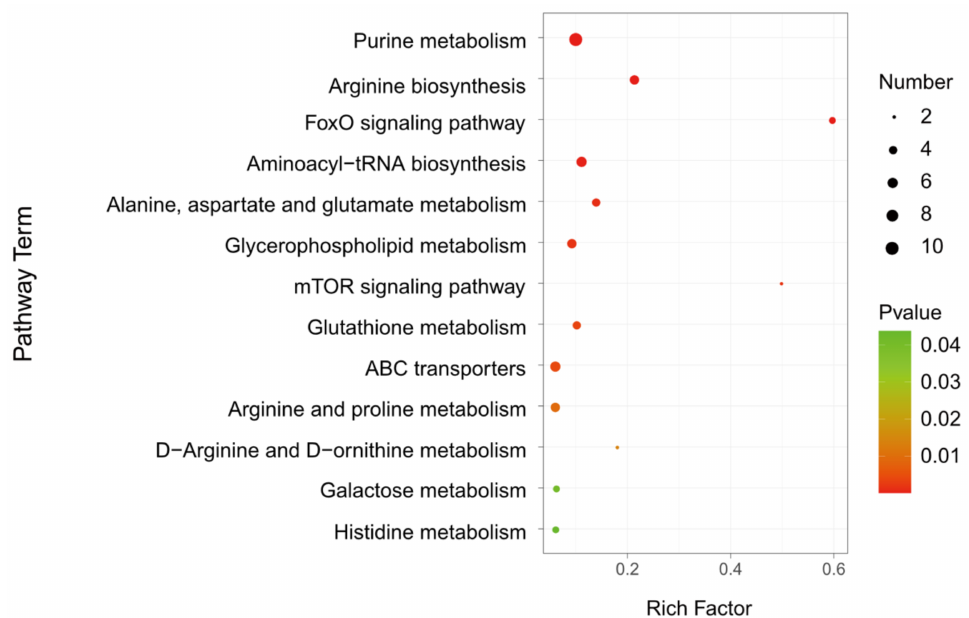
Figure 6. KEGG analysis of the differential metabolites in D. melanogaster hosts post A. japonica parasitization. KEGG analysis of differential metabolites in parasitized and non-parasitized hosts. The larger the rich factor, the greater the enrichment degree; the color from green to red indicates that the p -value decreasing. The larger the point, the more metabolites enriched in the pathway. Table 1. Significantly enriched metabolic pathways, identified in different